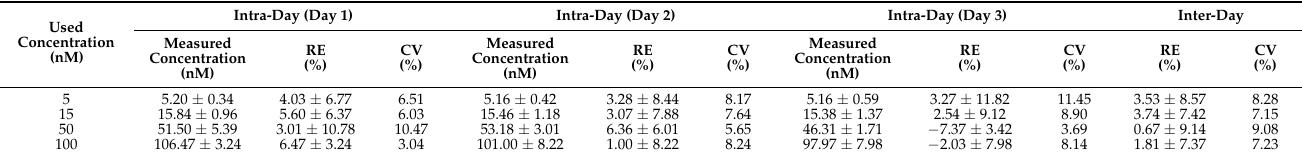
Figure 3. Chromatograms obtained in the LC–MS/MS analysis of ( A ) a blank sample, ( B ) a sample with 5 nM silmitasertib (LLOQ), ( C ) a 15 nM silmitasertib standard sample, and ( D ) a 100 nM silmitasertib standard sample. Shown are exemplary chromatograms of the quantifier ions for silmitasertib and the internal standard acridine orange. Not shown are the qualifier ions for silmitasertib ( m/z 314.1) and the internal standard ( m / z 234.1). Table 1. Inter-day and intra-day accuracy, expressed as relative error (RE) ± standard deviation (SD) and precision, determined as coefficient of variation (CV), of five different samples, each from three days of silmitasertib at LLOQ level (5 nM), low (15 nM), medium (50 nM), and high (100 nM) concentrations. The measured concentrations are given as mean values ± SD; n = 5 for intra-day, n = 15 for